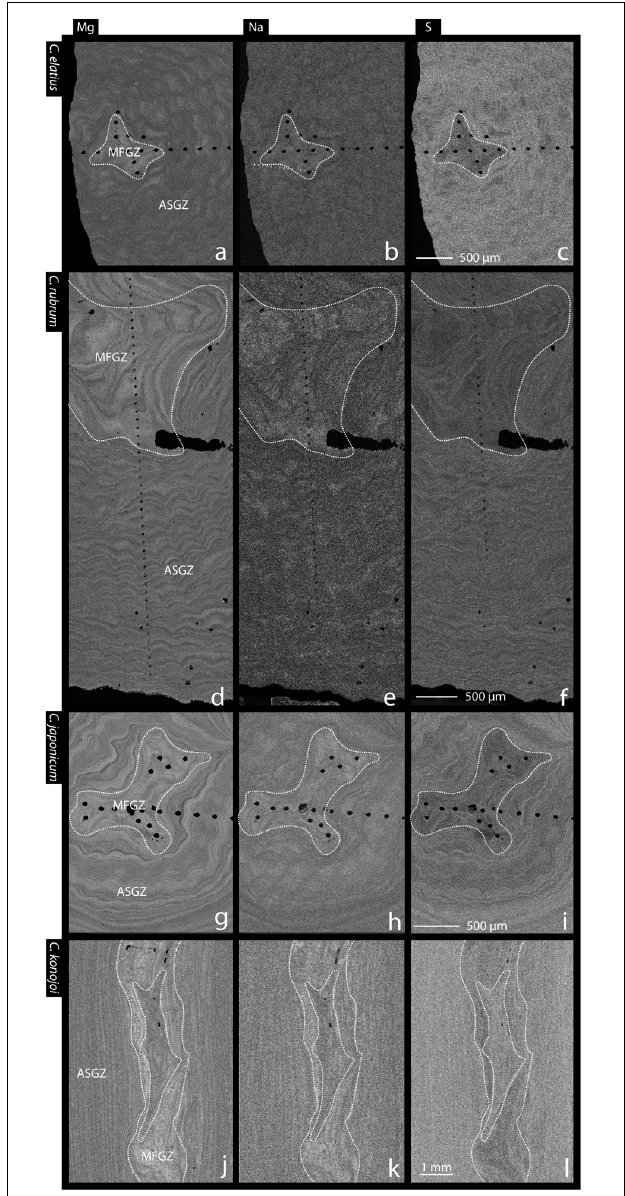
FIGURE 6 | Mg, Na and S EMP maps of Corallium skeletons. (a–c) Transverse section of C. elatius . (d–f) Transverse section of C. rubrum . (g–i) Transverse section of C. japonicum . (j–l) Longitudinal section of C. konojoi . White dashed lines encircle medullar zones. ASGZ, annular slow growing zone; MFGZ, medullar fast growing